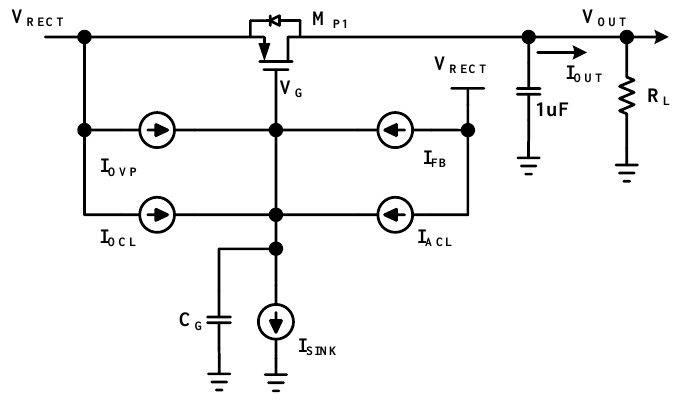
Figure 6. Simplified function diagram of multi-feedback LDO.